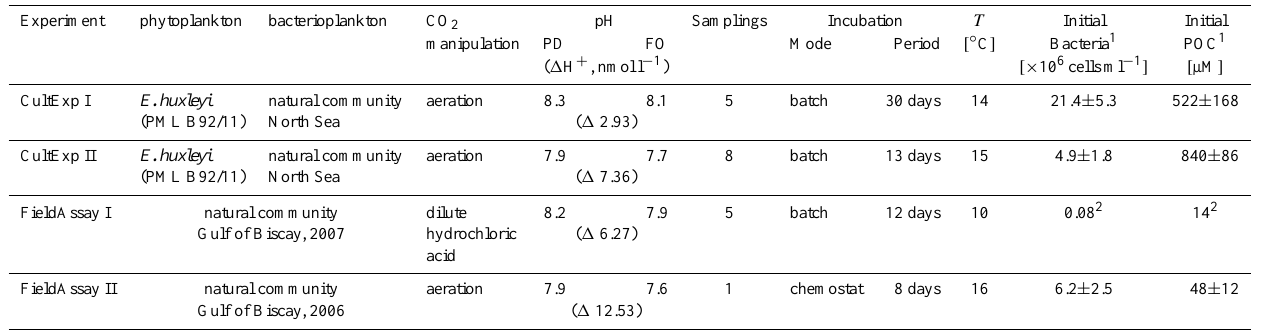
Table 1. Setup of culture experiments (CultExp I, CultExp II) and field assays (FieldAssay I, FieldAssay II). Experiment phytoplankton bacterioplankton CO 2 pH Samplings Incubation T